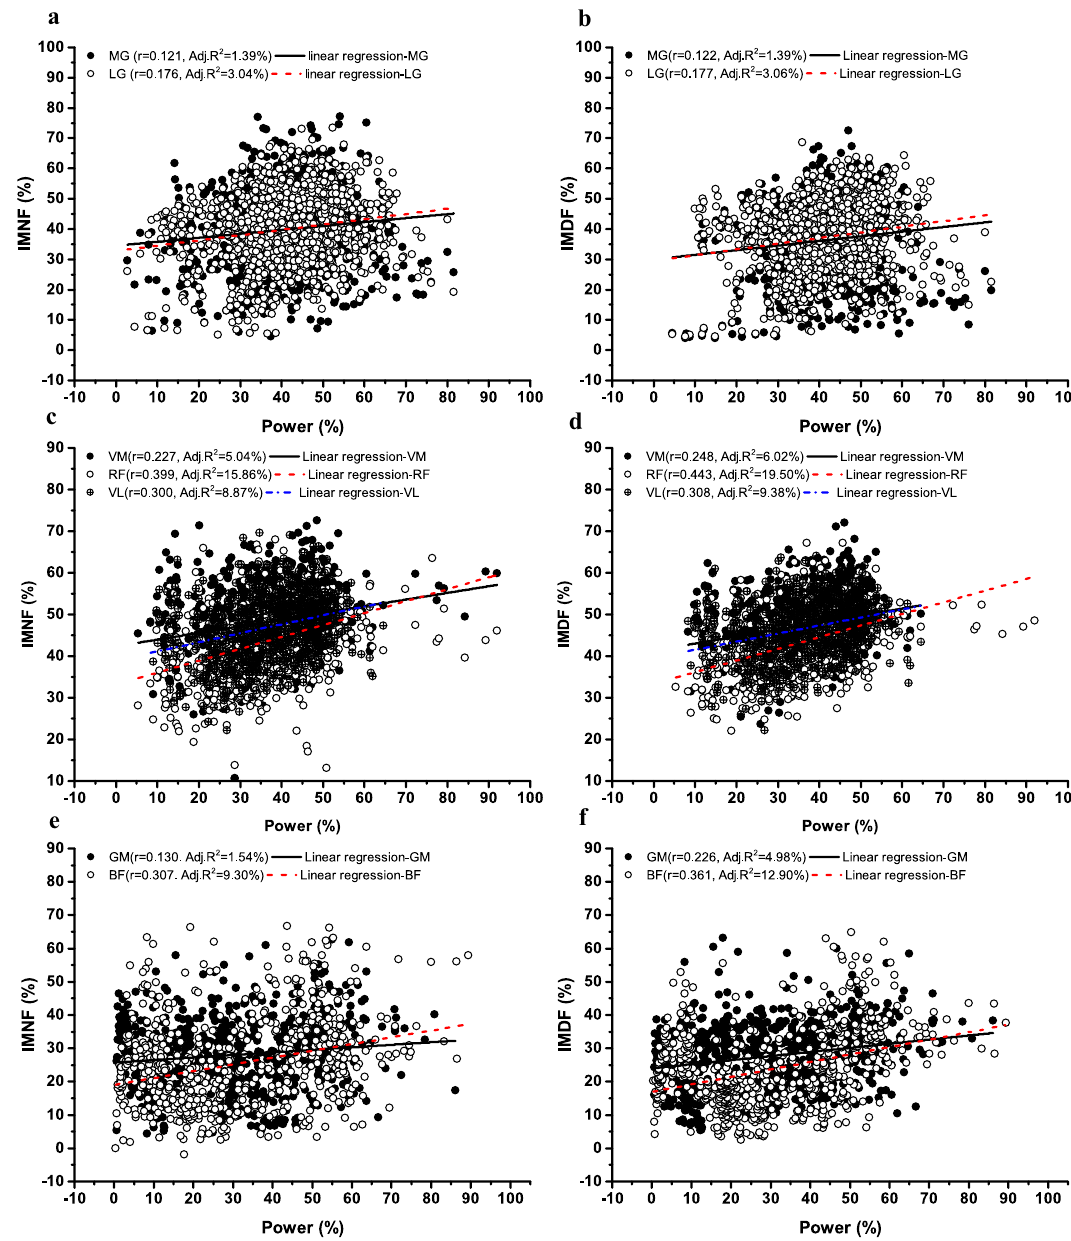
Figure 3. The association between changes in percentage of power output and changes in percentage of instantaneous frequency parameters (percentage of the first two repetitions). Note : IMNF instantaneous mean frequency, IMDF instantaneous median frequency. MG medial gastrocnemius, LG lateral gastrocnemius, VM vastus medialis, RF rectus femoris, VL, vastus lateralis, GM gluteus maximus, BF biceps